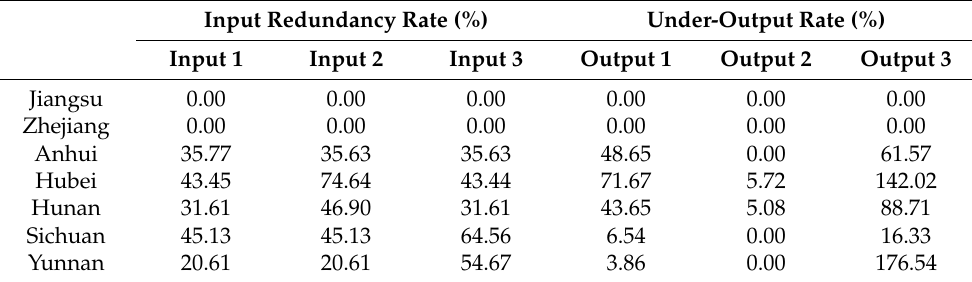
Table 7. Input-output analysis of environmental governance efficiency in the YREB (Yangtze River Economic